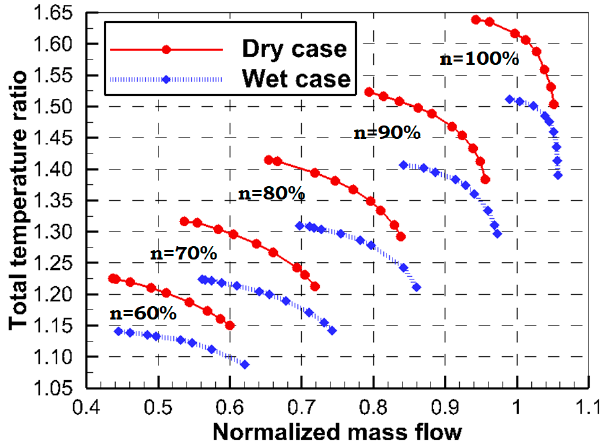
Figure 6. Contrast diagram of temperature ratio under dry and wet cases in a multistage compressor.